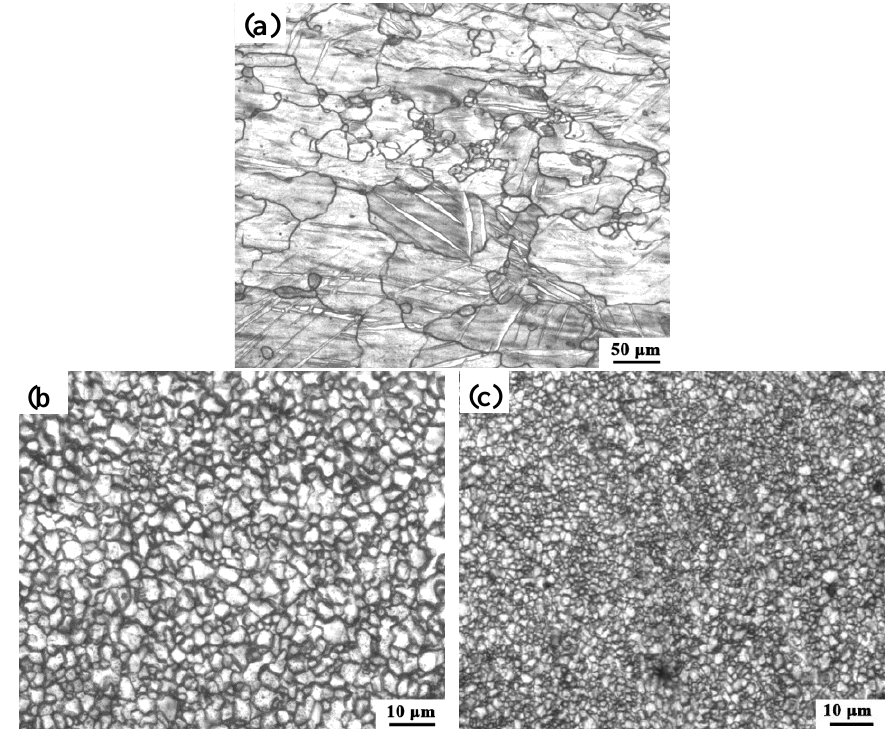
Figure 3. Microstructures of the experimental material: ( a ) BM; ( b ) SZ processed in air; ( c ) SZ processed